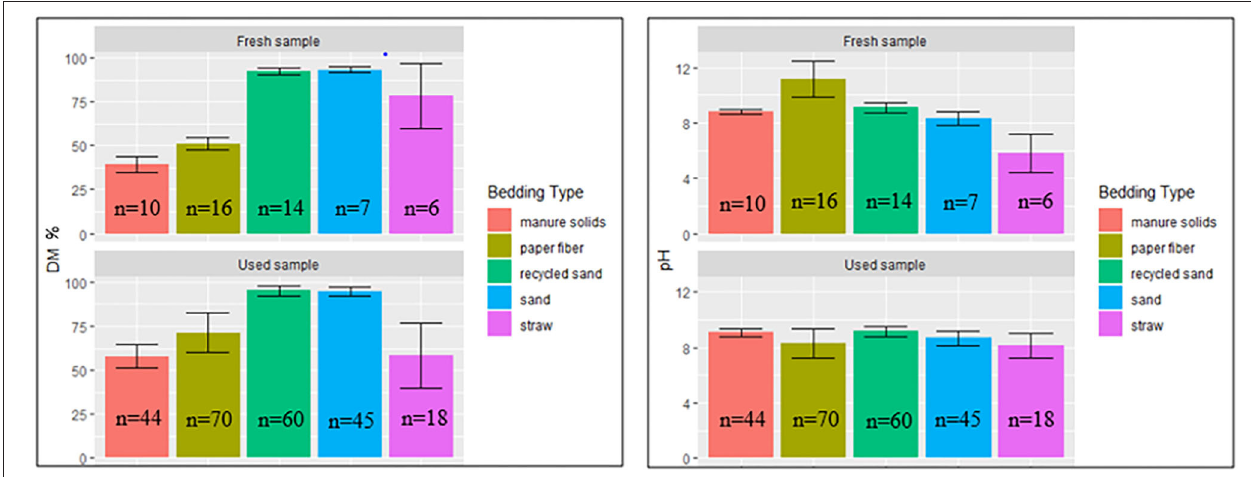
FIGURE 4 | Average DM content (% DM) and pH values (Error bars represent SD) for fresh and used bedding samples collected from July 2018 to July 2019 from five conveniently selected New York dairy herds using one of five bedding materials in lactating pens. One fresh bedding sample and three to five used bedding samples were collected monthly following an SOP at each visit (unless there was no bedding available due to lack of supply or equipment malfunction on the follow-up visit).